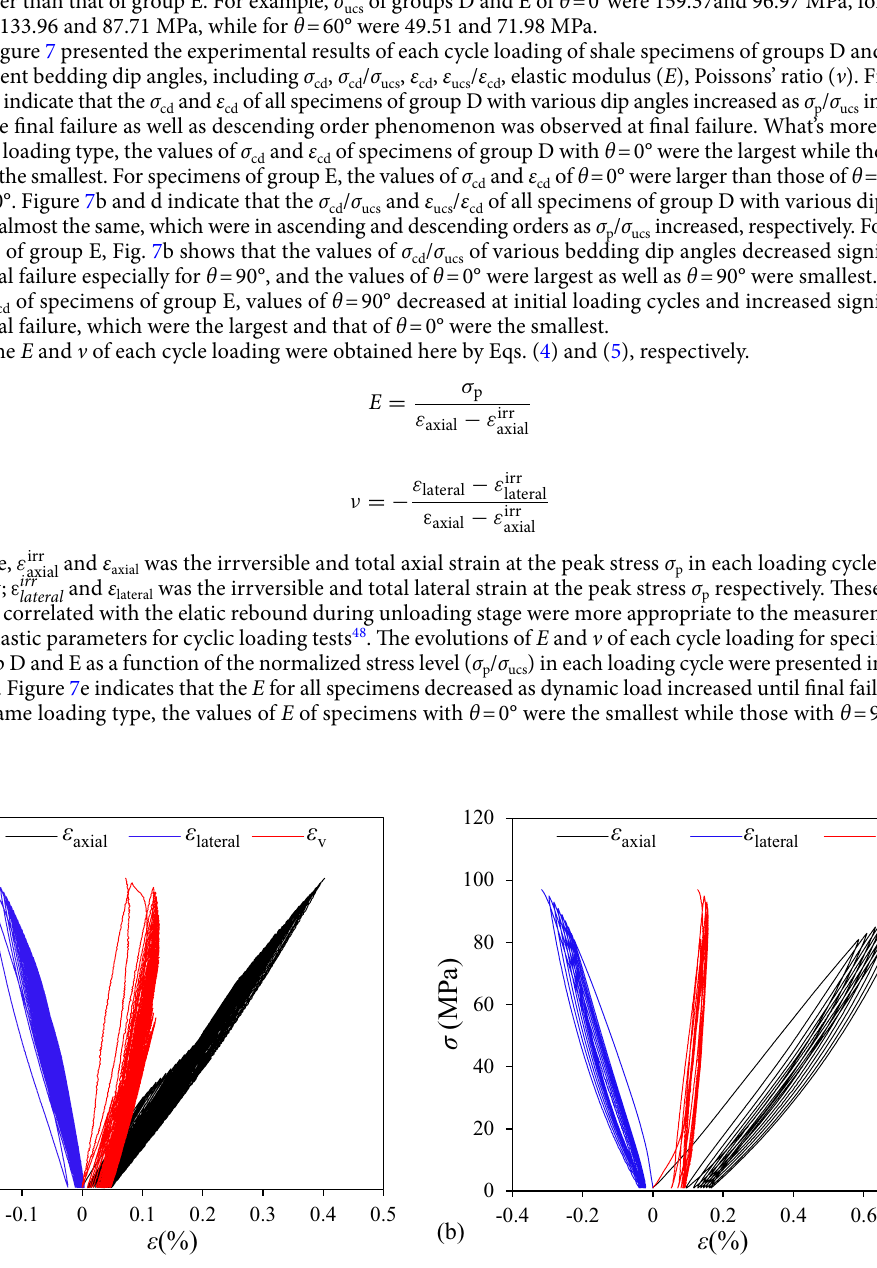
Figure 6. The stress–strain curves of specimens of ( a ) θ = 90° in group D and ( b ) θ = 0° in group